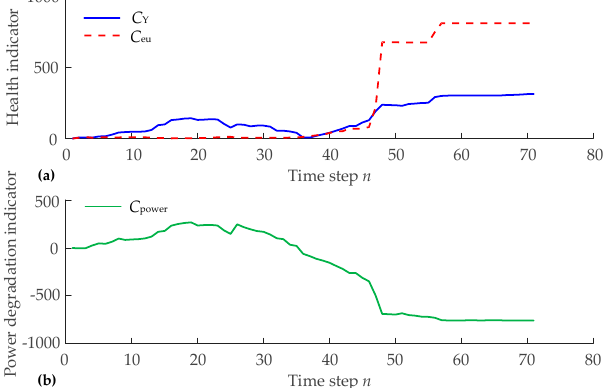
Figure 4. Comparison of the health indicators of wind turbine operating conditions (total time step n = 73).